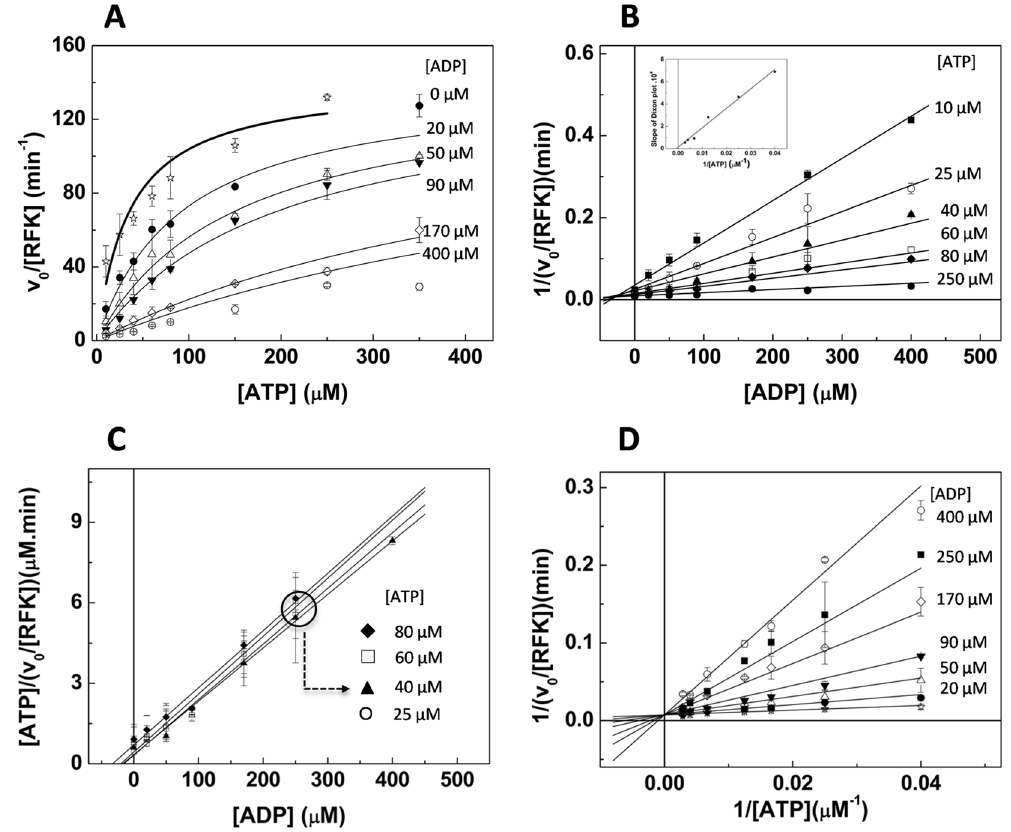
Figure 1. Inhibitory effects produced by the ATP substrate and the ADP product in the steady-state RFK activity of the RFK module of Ca FADS. ( A ) Michaelis-Menten plots as a function of the ATP substrate concentration at different concentrations of the ADP product, and the corresponding ( B ) Dixon plot with the representation of the slopes vs 1/[ATP] in the inset, ( C ) the corresponding Cornish-Bowden plot and ( D ) the Lineweaver-Burk representation. In ( A , C and D ) lines correspond to global fits to the equation for competitive inhibition. Reaction rates were obtained in 20 mM PIPES and 0.8 mM MgCl 2 , pH 7.0, at 25 °C, with 5 μ M RF (concentration at which the enzyme shows 80% of its maximal apparent activity at saturating levels of ATP), while the concentrations of the ATP substrate (10–350 μ M) and the ADP product (0–400 μ M) were